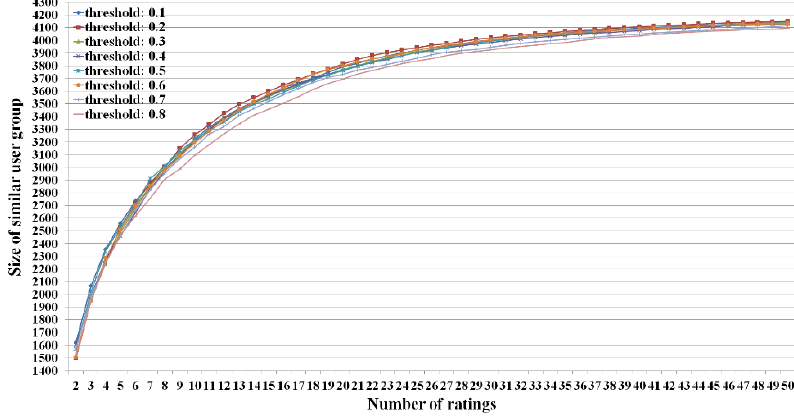
Figure 7. Size of similar user group according to the different numbers of ratings based on the cosine similarity.